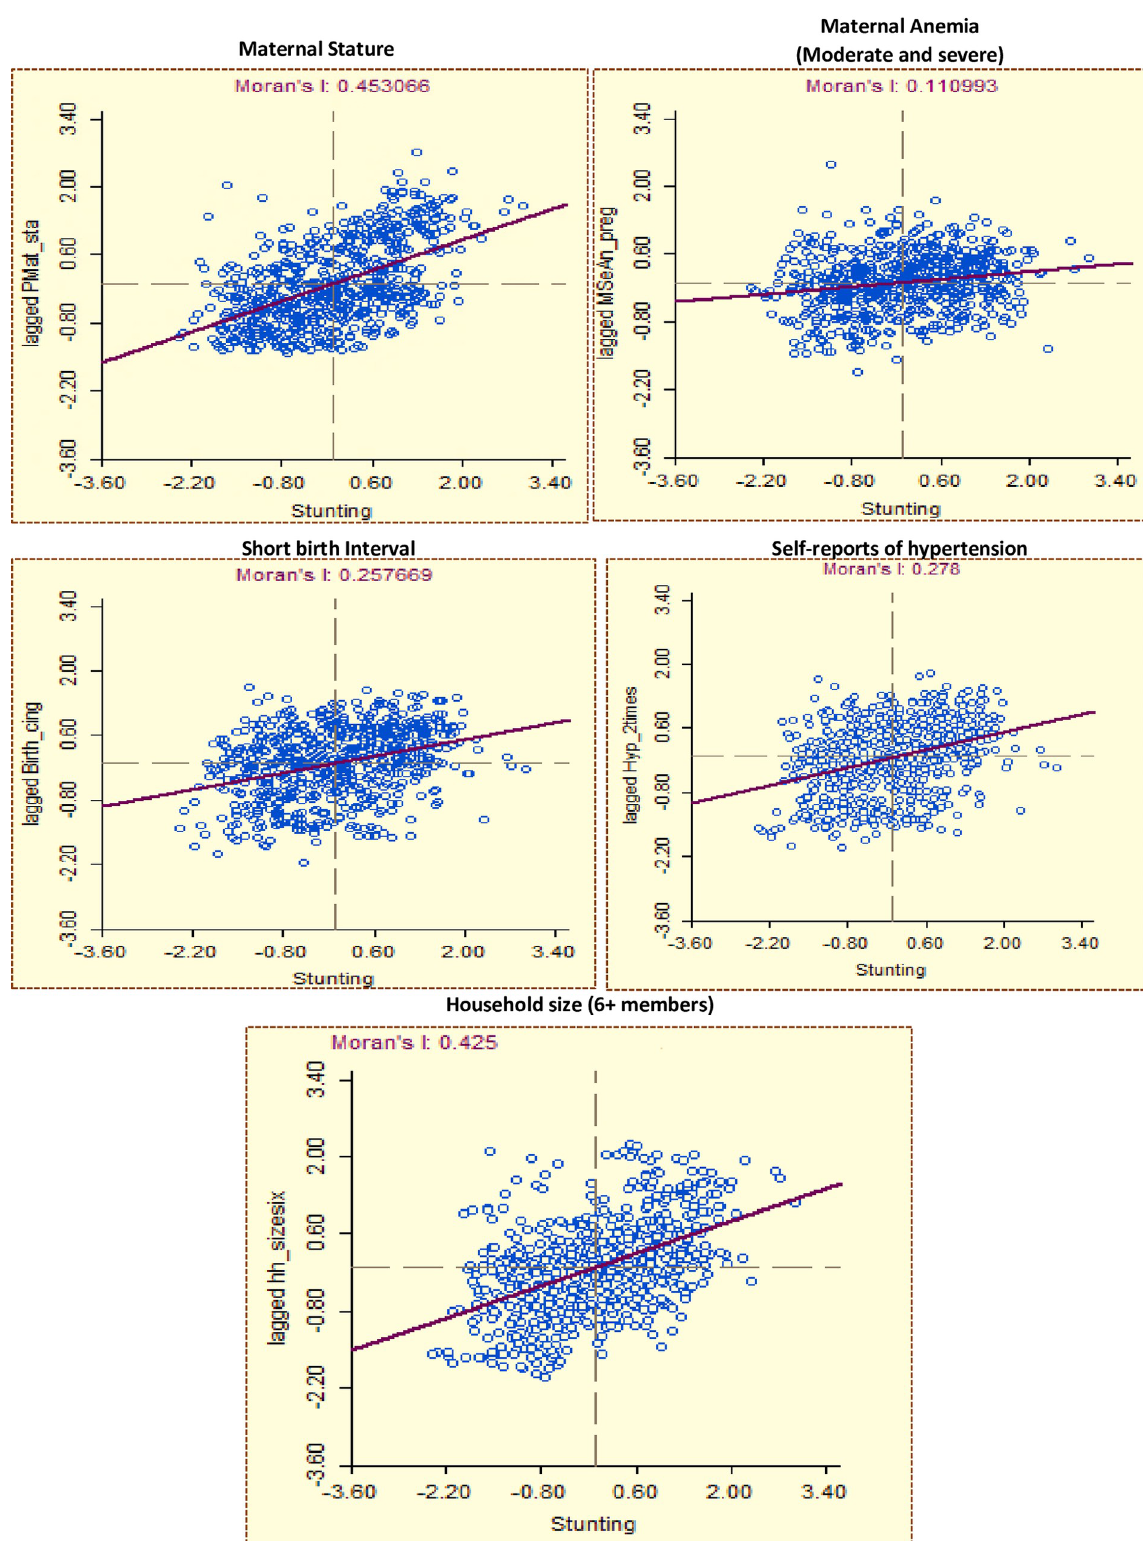
Fig 3. Bivariate spatial association between childhood stunting and explanatory variables.